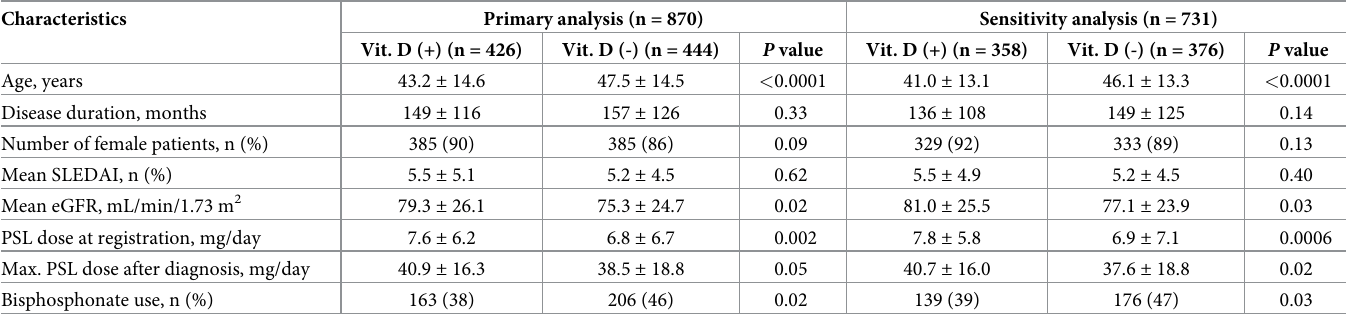
Table 1. Comparison of patient